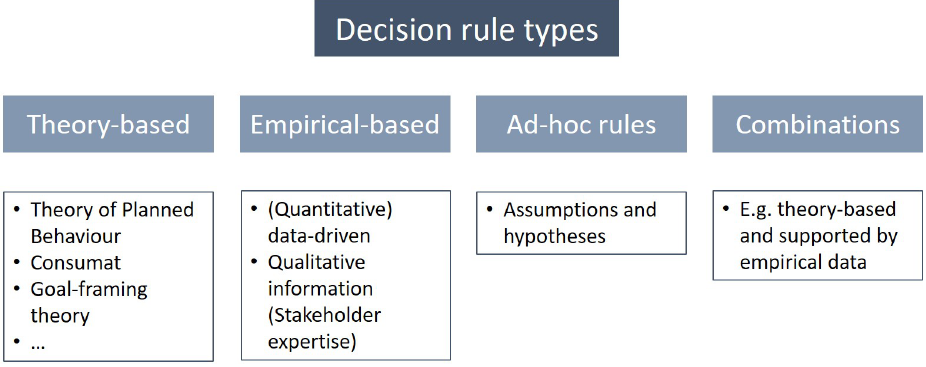
Figure 5. Types of decision-making